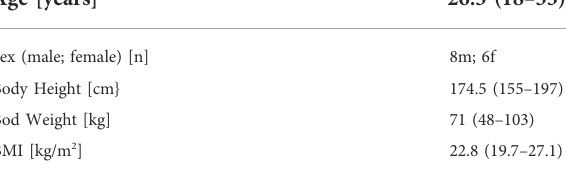
TABLE 1 Study population data (median and range).